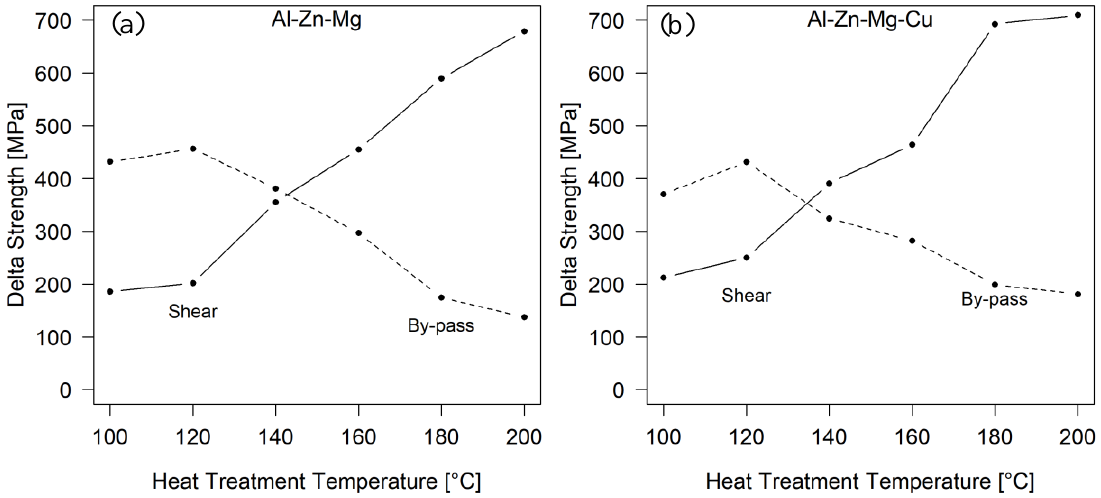
Figure 9. Estimated delta strength from shearing and by-pass precipitation hardening mechanisms for ( a ) Al-Zn-Mg alloy and ( b ) Al-Zn-Mg-Cu alloys after various 3 h isothermal heat